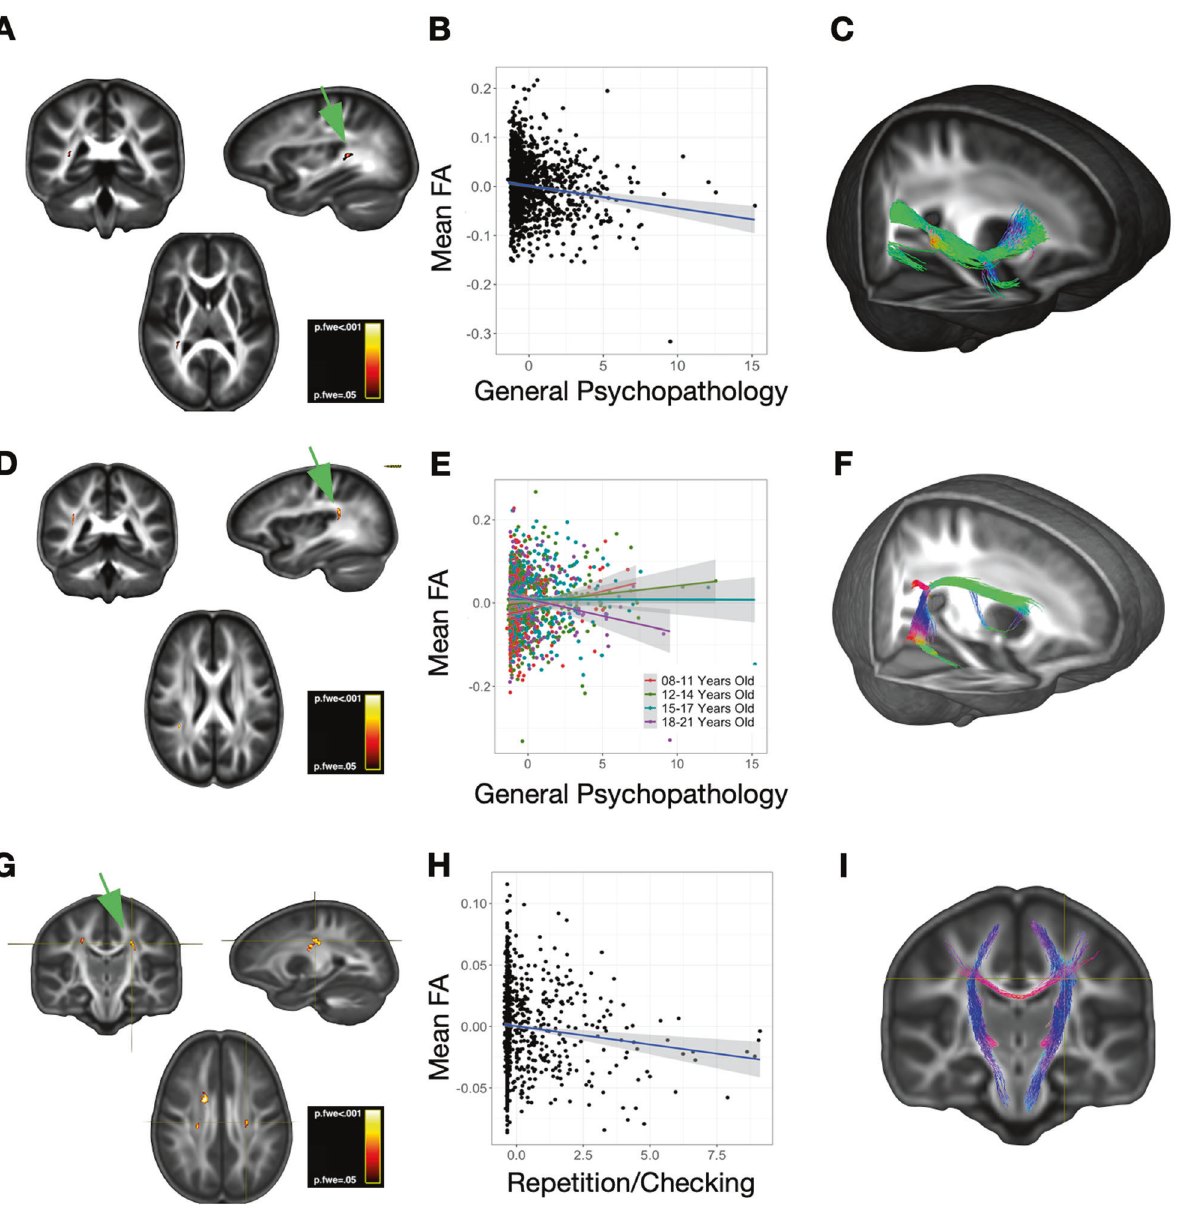
Fig. 4 Fractional anisotropy results from whole-brain analyses. The right column displays the localization of signi fi cant effects for each trait ( A , D , G ). The center column presents post-hoc scatterplots with fi t lines to illustrate the effects of interest ( B , E , G ). Note that panel ( E ) shows an age-dependent effect, whereby the lowest quartile age range demonstrated a positive association between p-factor scores and FA, but the highest quartile age range showed an inverse association. Scatterplots of these effects were generated post-hoc, and should not be interpreted as correlations. In the right column, FA results were used to as seed regions to generate probabilistic tractograms ( C , F , I ), which serve to further characterize the likely pathway(s) intersecting the localization of the FA fi from the region associated with the interaction of general It is striking that the general psychopathology factor (Fig. 2) and psychopathology with age. The Symmetry OCS dimension is also the OCS dimensions of Bad Thoughts, Repetition/Checking, and associated with anterior corpus callosum abnormalities and is the Symmetry (Fig. 3A, G, J) are all associated with white-matter only psychopathology dimension to demonstrate associations abnormalities in the posterior corpus callosum. Closer examination with any frontal white matter region. revealed that the affected regions are not identical (Supplemen- It is notable that we did not observe any signi fi cant associations tary Fig. 3). The correlate of the Bad Thoughts dimension is more between general psychopathology and fi ber metrics (including dorsal in the corpus callosum than the other factors, with FA) in frontal or frontotemporal pathways. This contrasts with a corresponding seed-generated white matter streamlines extend- previous report of an analysis conducted in a subsample of this ing into the dorsal parietal lobe. In contrast, the white-matter same dataset [9]. This inconsistency may be due to substantial regions associated with the Repetition/Checking and Symmetry method variance, since Alnæs et al. [9] examined ICA-derived dimensions are more ventral, with streamlines extending into the white matter “ factors ” based on the covariation of multiple posterior parietal/occipital lobe, and are dif fi cult to distinguish